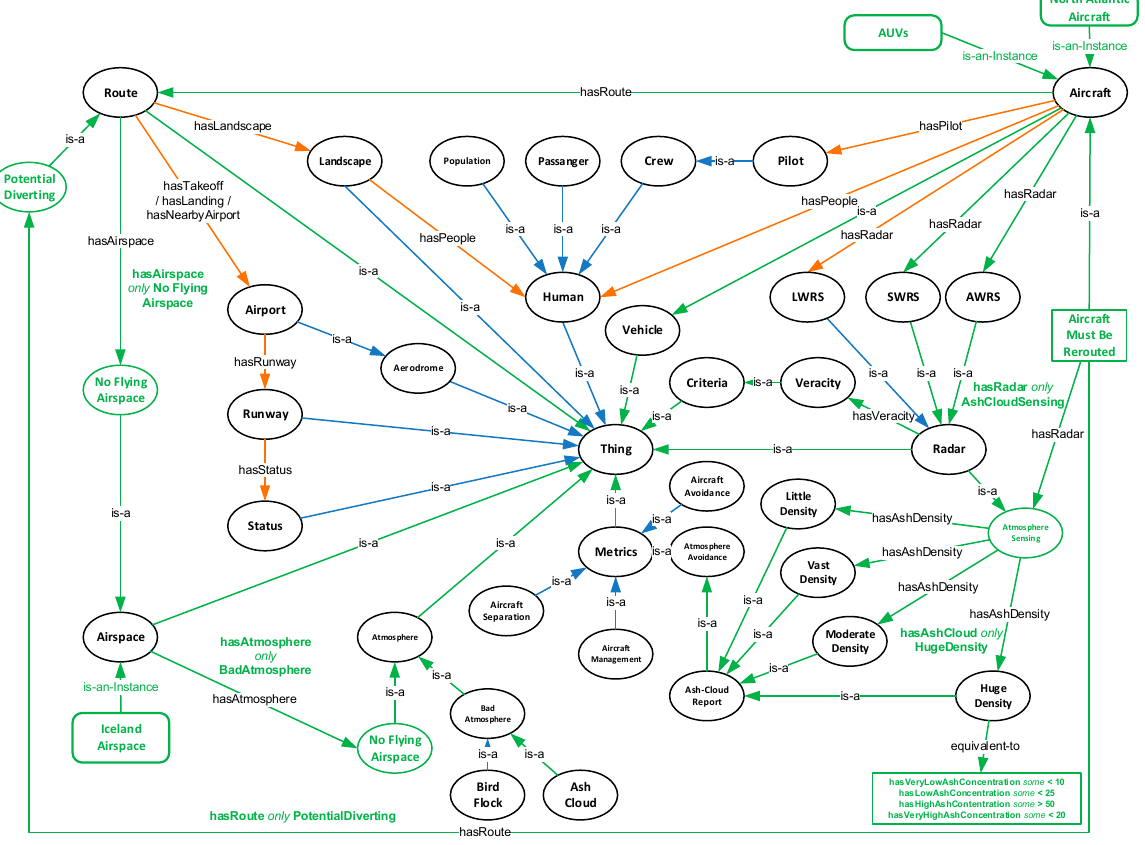
Figure 17. Reasoning behind the queries for airspace situation in Scenario 2. Figure 18 shows the AAO results from different queries carried out to assess whether an aircraft must modify its route on its way from Europe to America, or all the way around. The results consider the veracity of EOsatImg and the UAV sensors to detect the concentration in the ash cloud from the Eyjafjallajokull volcano. The query results answer the question of what the chance are for the above aircraft to have to modify its airway because of the ash cloud. The chances depend on the veracity of the information provided by the two sensing mechanisms (satellite images and UAV sensors). The AAO query results from the SSBN considering the satellite and the UAV instru- ments, and a combination of their measurements, suggest that (from left to right): High chance of modifying the airplane route (when EOsatImg detects the ash concentration from the ash cloud). Aircraft should change route to avoid the ash cloud on their airway as the EOsatImg radar suggests a probability of 53.60% for an ash concentration between 2000 and 4000 micrograms in the ash cloud. The veracity of this query